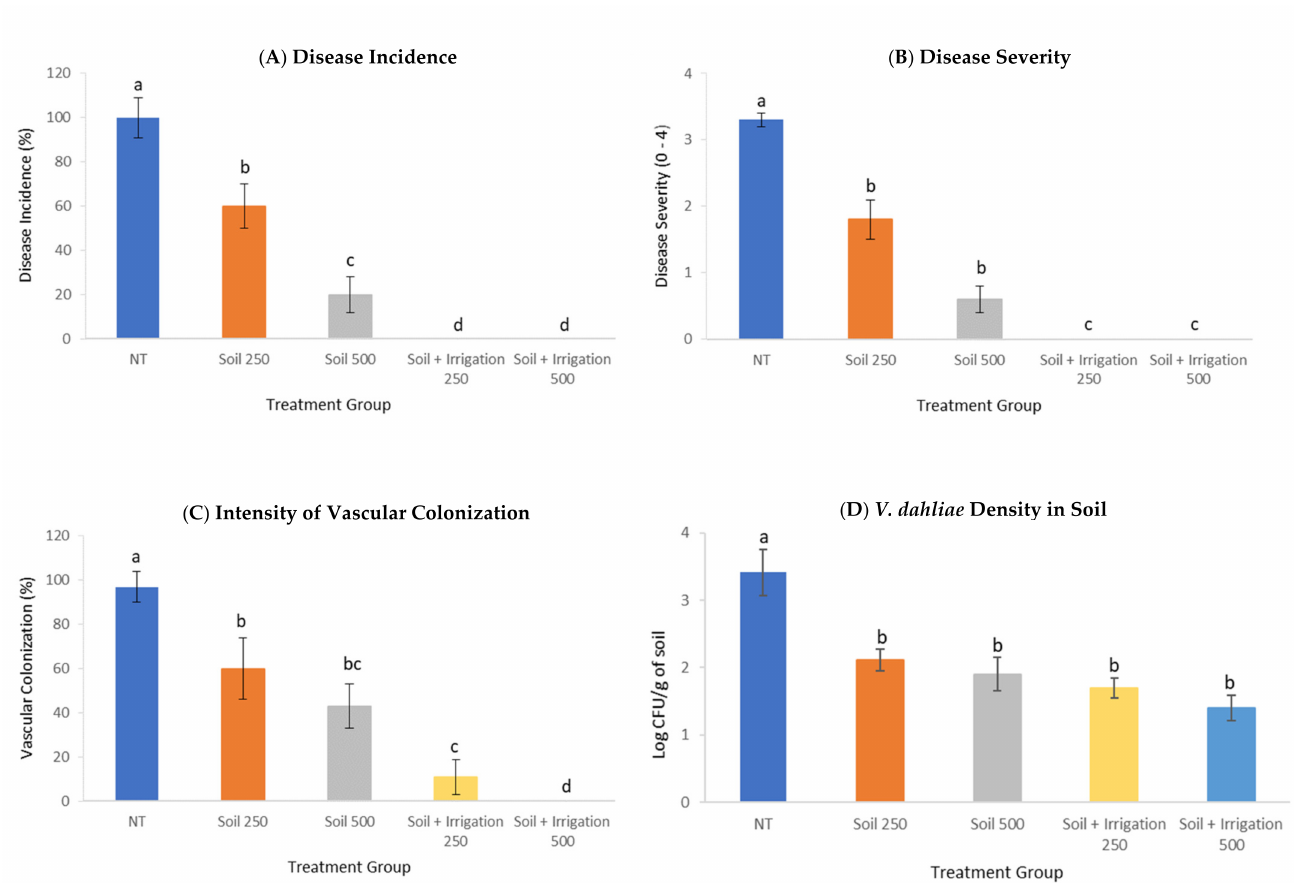
Figure 6. Disease reaction of olive trees of cv. Picual that grew in soil infested with the defoliating Verticillium dahliae (NT) pathotype treated with the blend of PTS and PTSO in 1:1 proportion at 250 and 500 µ g/mL, 92 days after transplanting to the infested soil: ( A ) Disease incidence expressed as percentage, ( B ) Disease severity expressed in scale from 0 to 4, ( C ) Intensity of vascular colonization expressed as percentage, ( D ) Density of V. dahliae in soil expressed as Log 10 CFU/g of soil. All panels include results from plants previously treated with the blend of PTS/PTSO or treated once with 100 mL of their respective dose one week later (Soil + Irrigation). For each panel, bars with a different letter indicate significant differences according to Tukey HSD test at p <